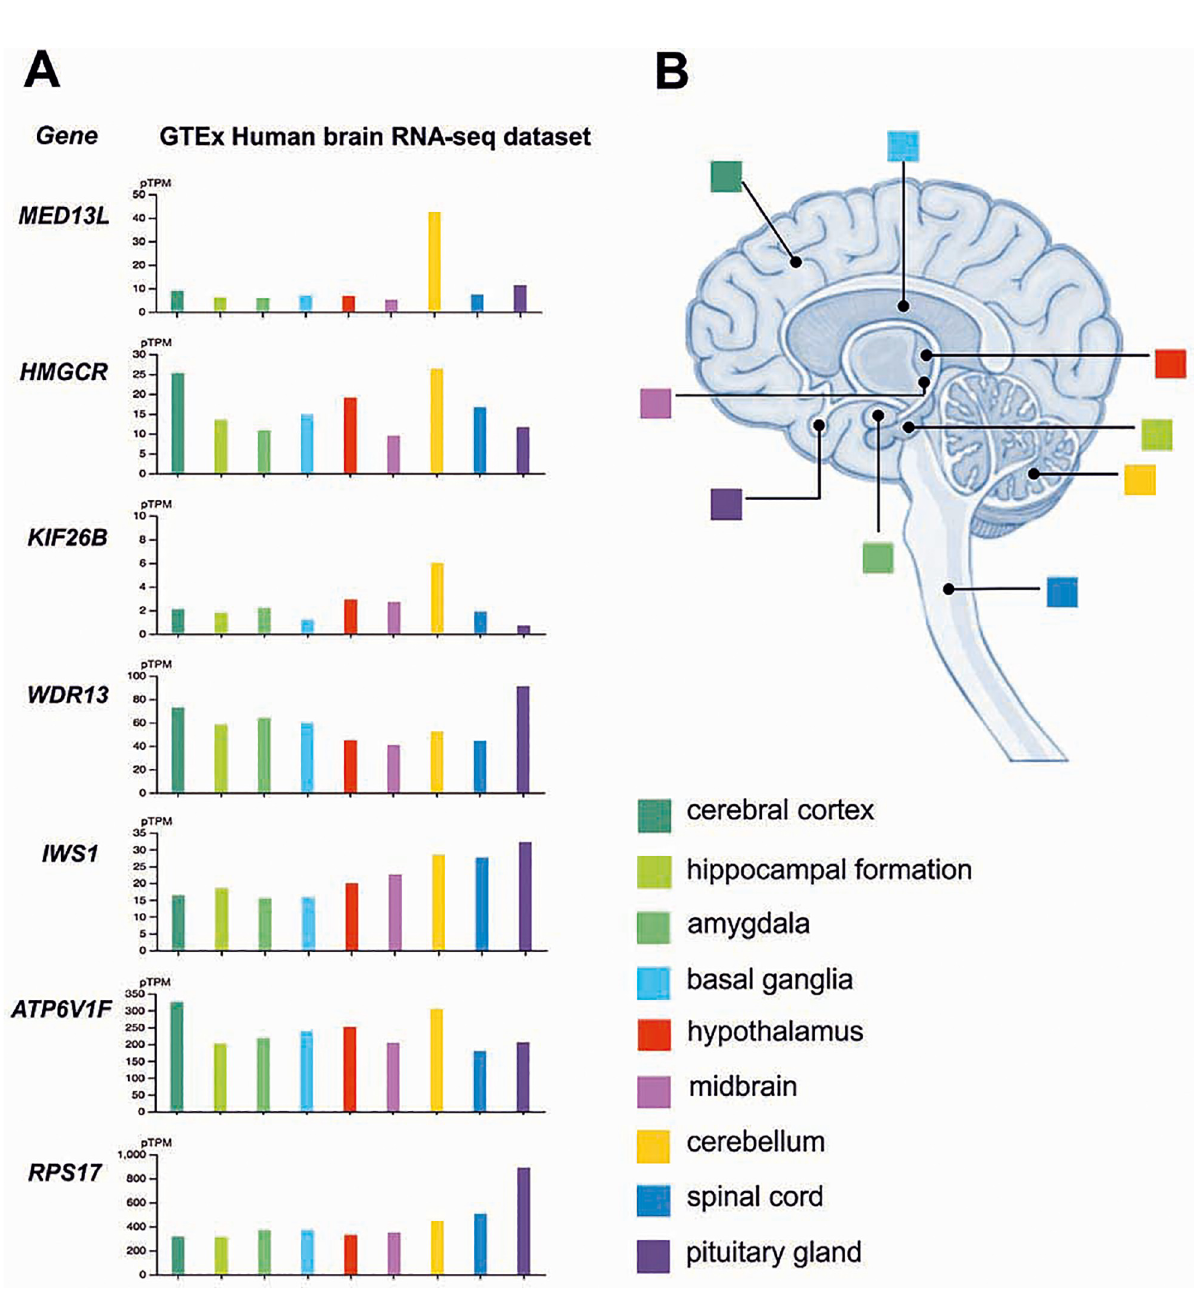
Fig 5. Images of gene expression profiles of ATP6V1F , HMGCR , KIF26B , IWS1 , MED13L , WDR13 and RPS17 obtained from the Allen Brain Atlas database (https://www.proteinatlas.org/). A. The panel of diagrams shows the expression distribution across brain regions depicted by average expression for each region. Color coding is based on the brain subregions regions shown in B. Expression data were reported as mean pTPM (protein- coding transcripts per million) corresponding to mean values of the different individual samples for respective subregion; B. Midsagittal schematic of the different regions of the human